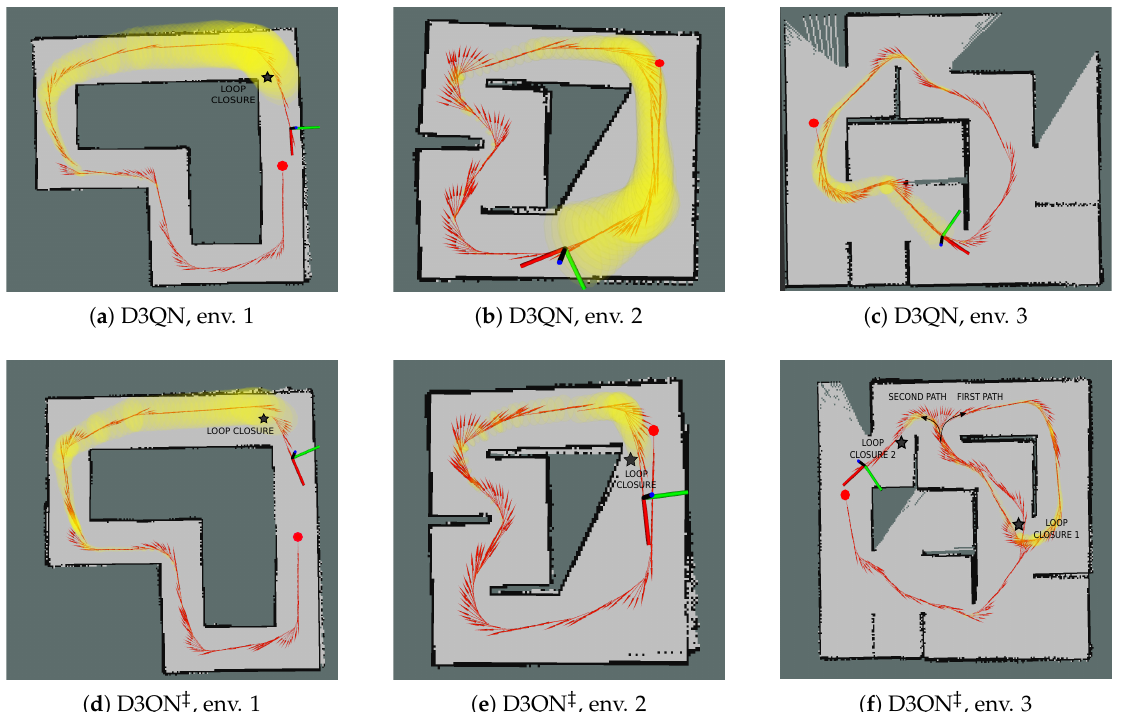
Figure 7. Maps built by D3QN (top) and D3QN ‡ (bottom) agents in the three environments during testing. Red circles indicate the starting position, red arrows the trajectory followed, black stars point out a resample of algorithm particles (loop closures) and yellow ellipses illustrate a measurement of the uncertainty of robot’s 2D